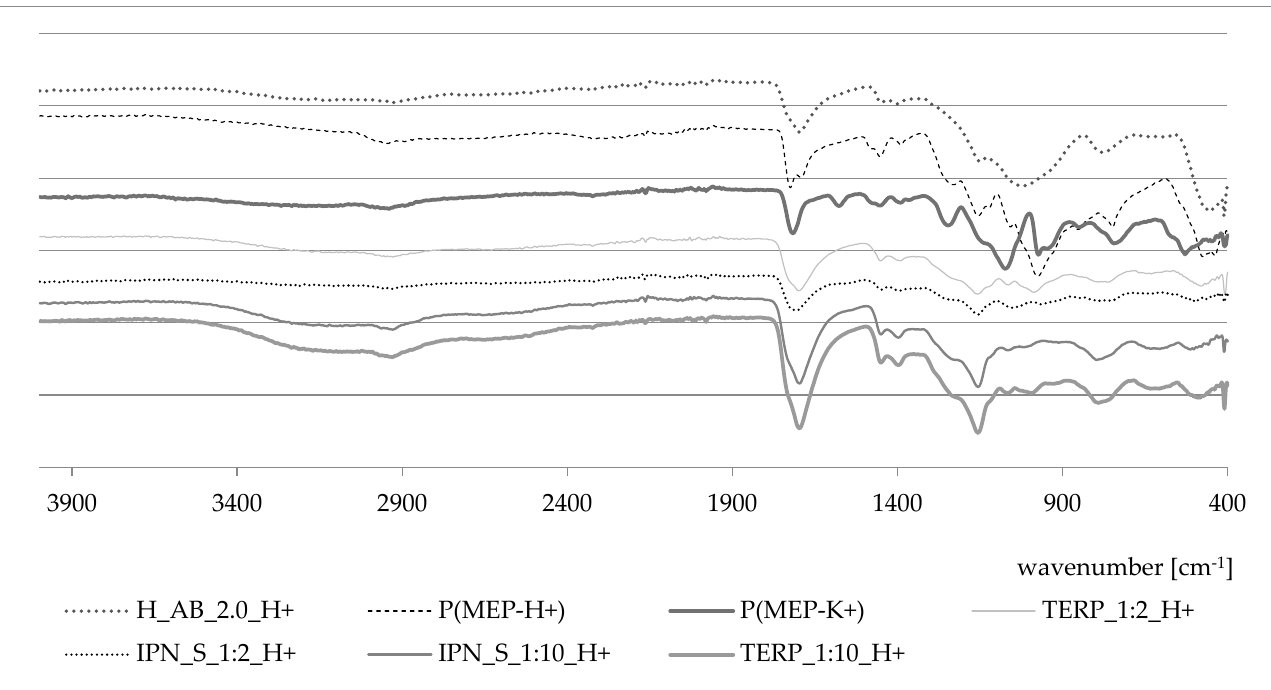
Figure 8. Changes in pH of the solutions above particular polymers.